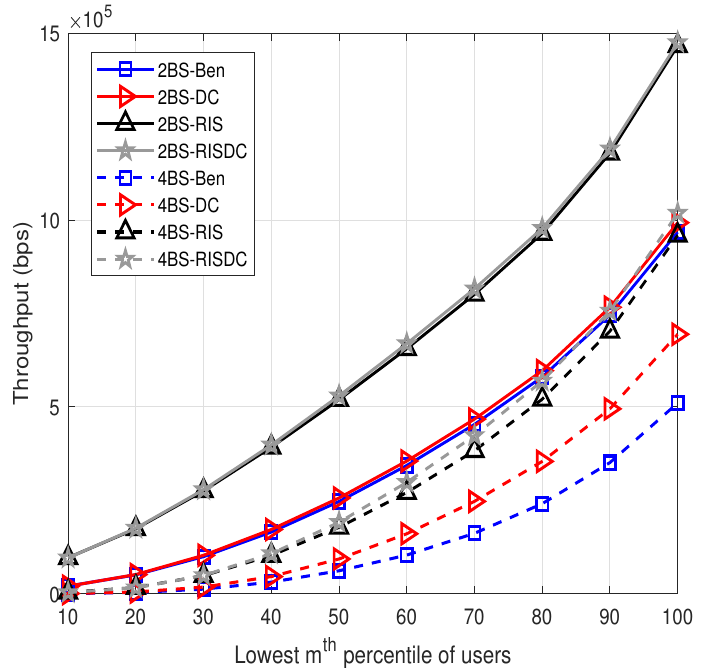
Figure 8. Variation of throughput with respect to lowest m th percentile of users when ρ bs = [ 2,4 ] , ρ user = 60, α = 1, and µ b = 10.